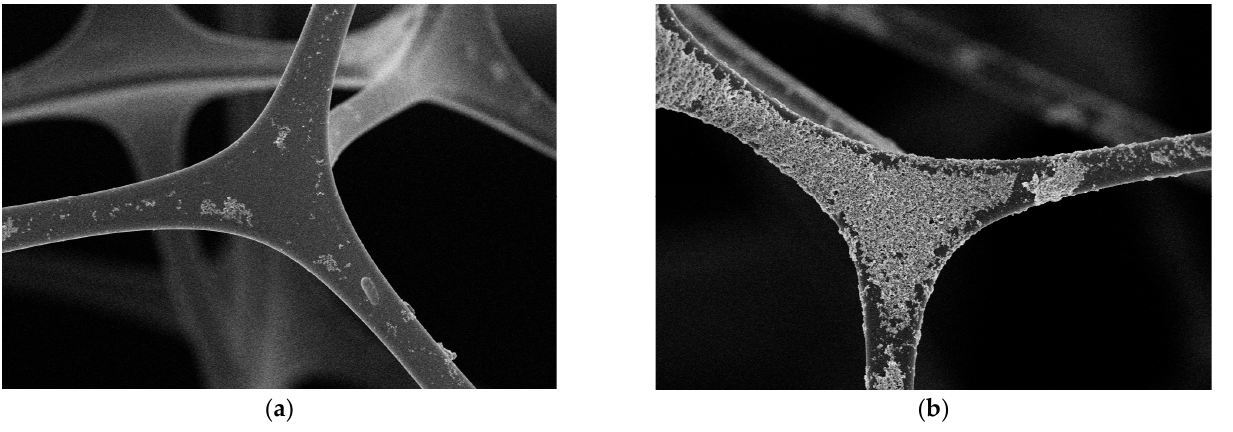
Figure 3. SEM images of ( a ) MS; ( b ) MS@PVC@SiO 2 .